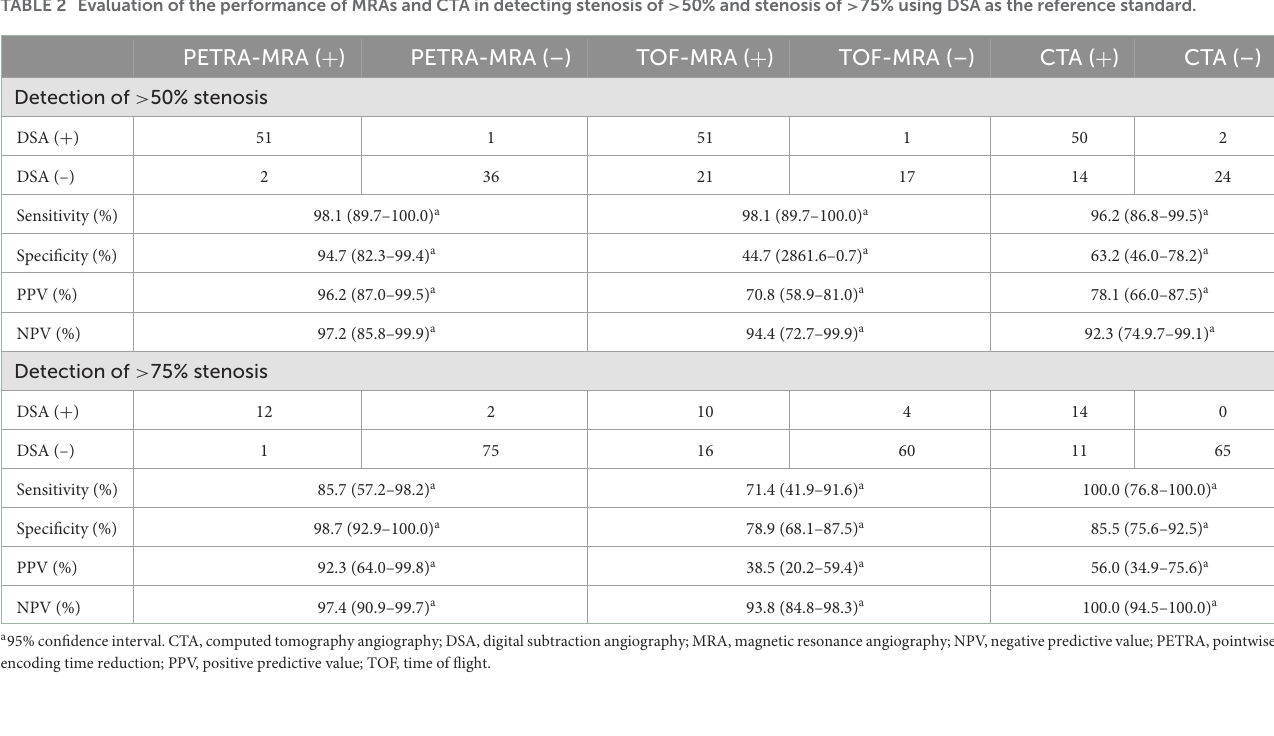
TABLE 2 Evaluation of the performance of MRAs and CTA in detecting stenosis of > 50% and stenosis of > 75% using DSA as the reference standard.